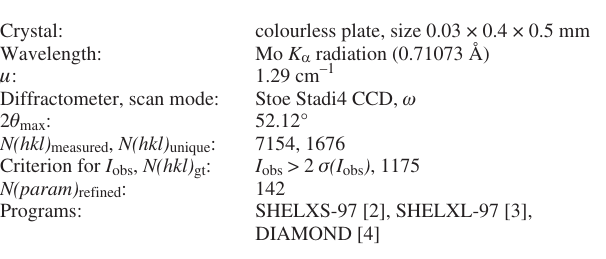
Table 1. Data collection and handling.